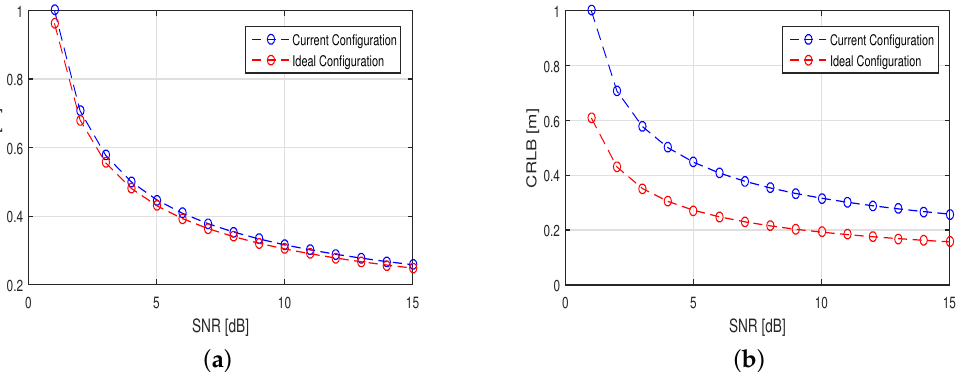
Figure 11. Cramer–Rao Lower Bound for ( a ) nine orbits of data set 1 and ( b ) twenty-eight orbits of data set 2.